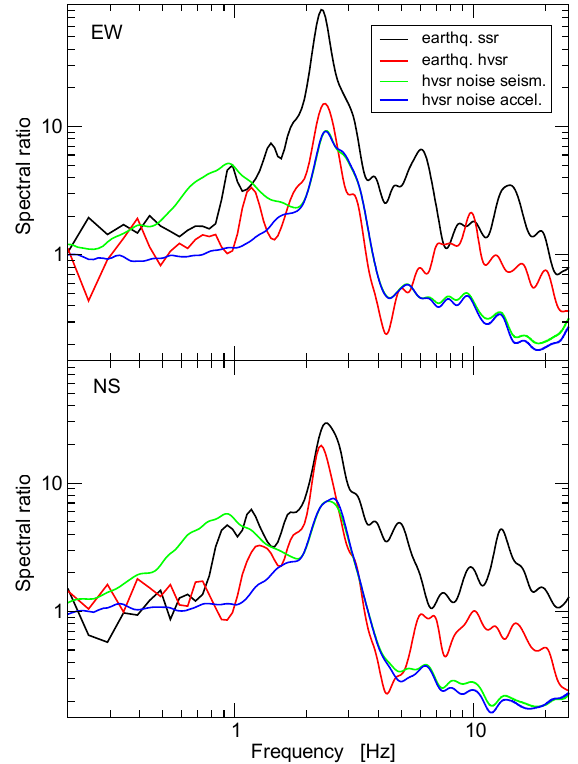
Figure 6. Average site effects estimated for station EST using earthquake data and ambient noise records. Earthquake data was analyzed using SSR and HVSR. Seismic noise was recorded using a seismograph (HVSR noise seism.) and an accelerograph (HVSR noise accel.). The two diagrams correspond to the two horizontal components.